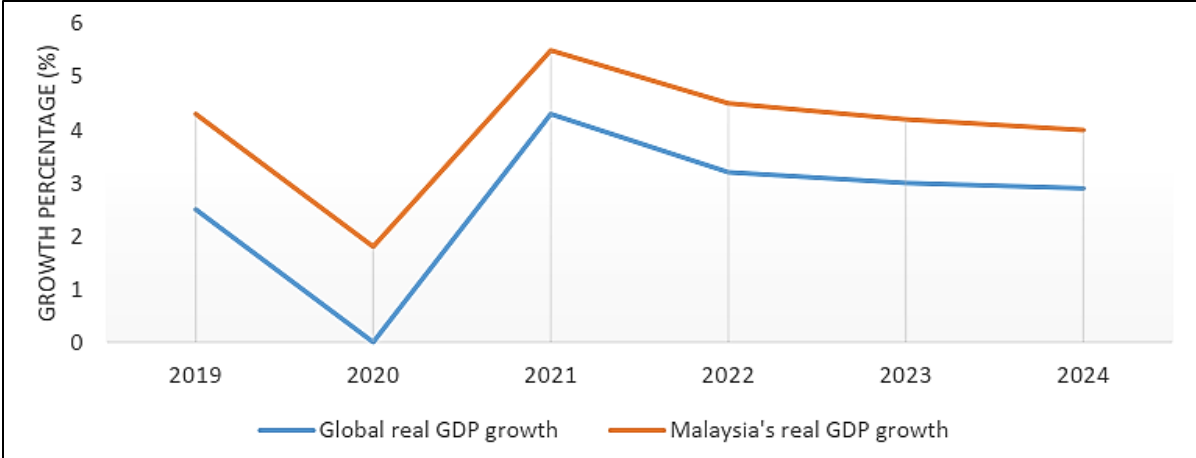
Figure 2. Economic Growth in